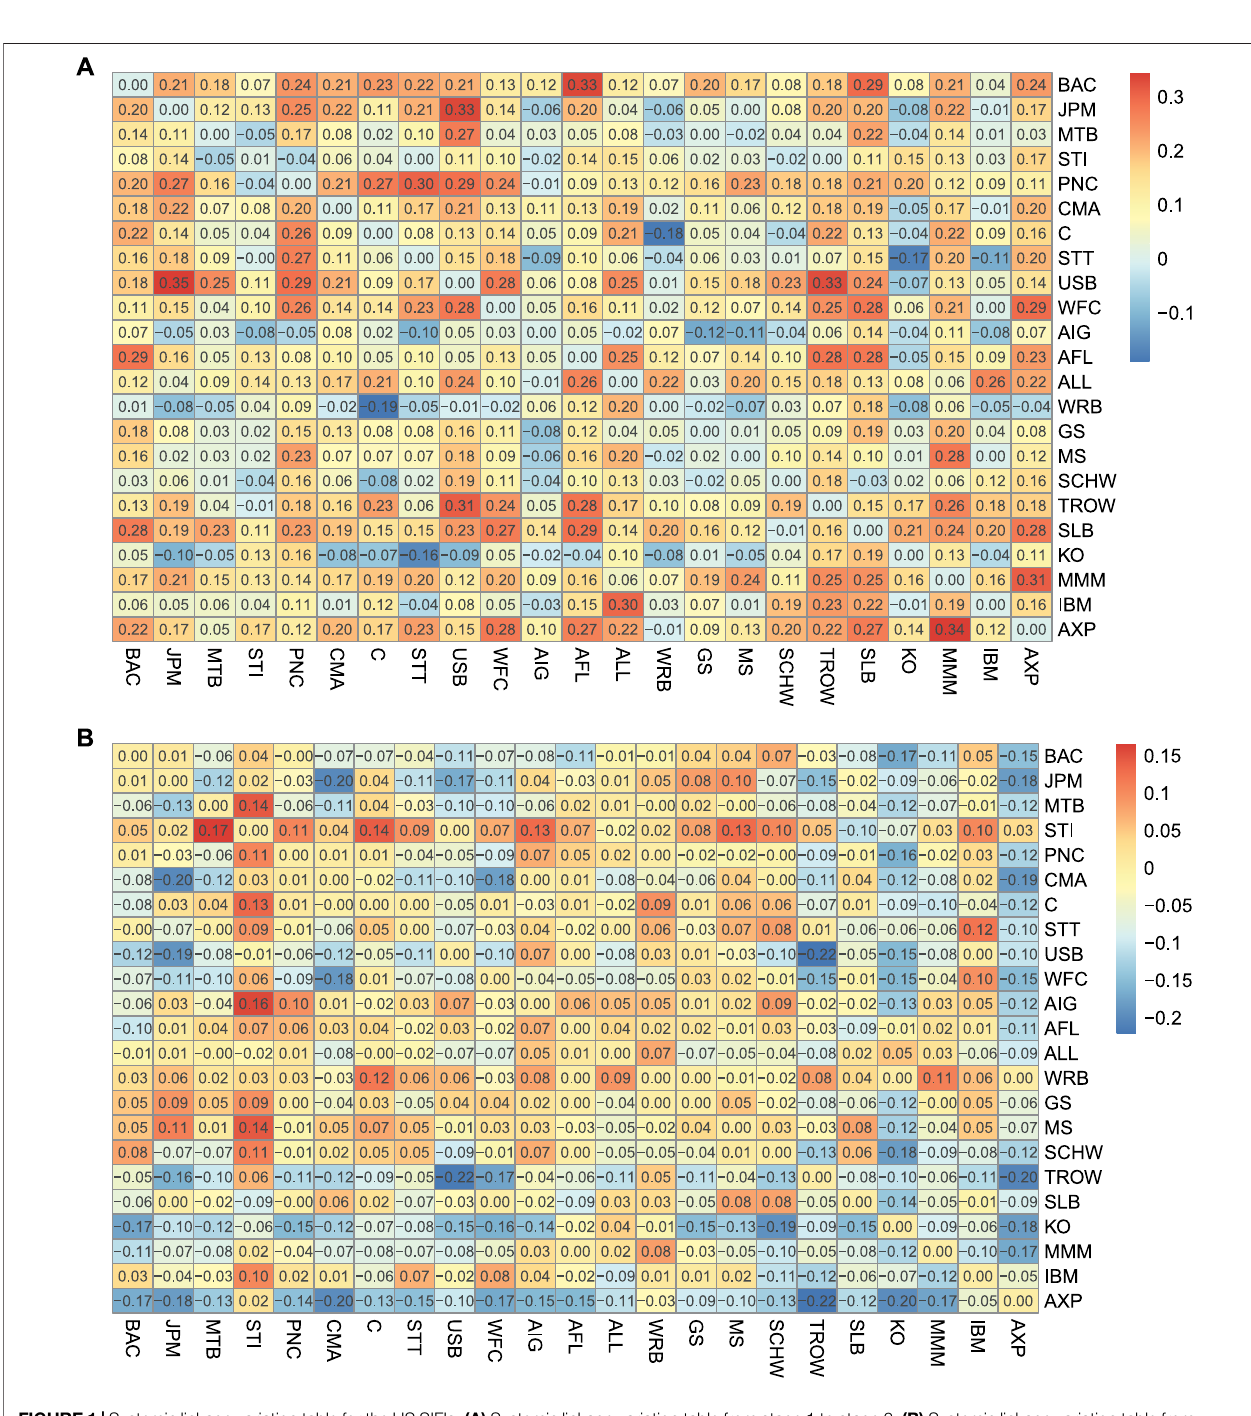
Frontiers in Physics |